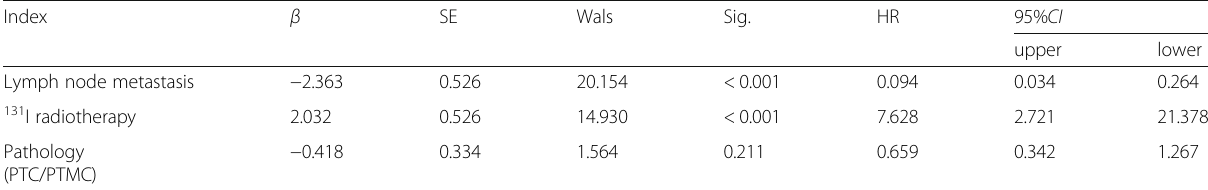
Table 4 Logistic regression analyses between BRAF V600E mutation group and BRAF V600E wild